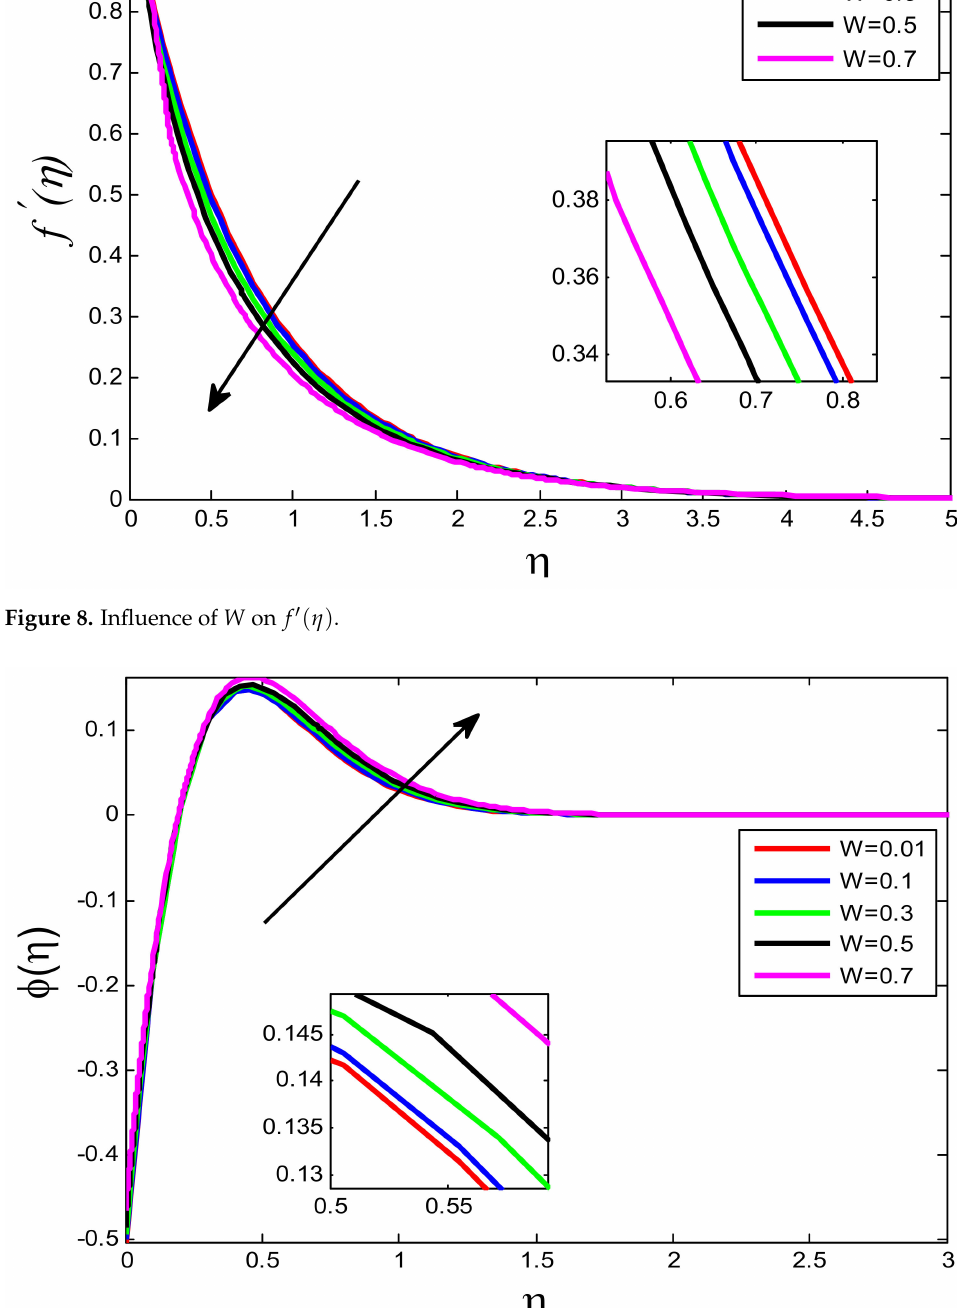
Figure 9. Influence of W on φ ( η )